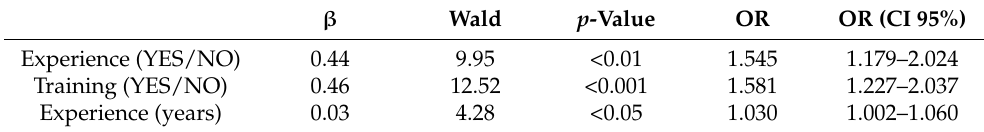
Table 7. Odds ratio and coefficients of variables included in the logistic regression model. β Wald p -Value OR OR (CI